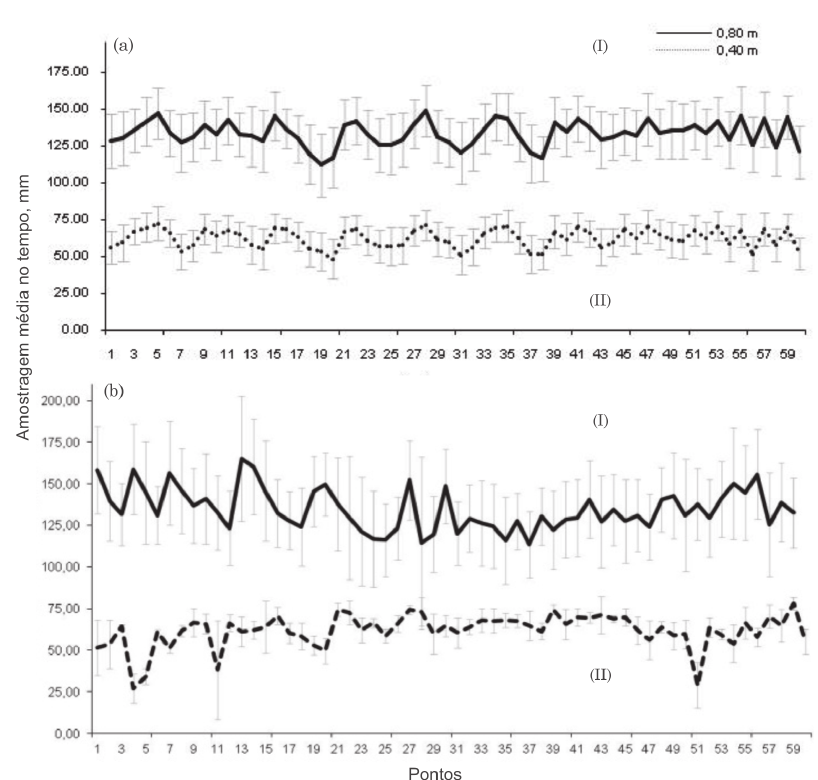
Figura 3. Média da armazenagem de água no solo de todos os pontos amostrados ao longo do tempo durante o ciclo de feijoeiro (a) e aveia-preta (b) para as camadas de 0-0,40 m (I) e 0-0,80 m (II) e respectivos